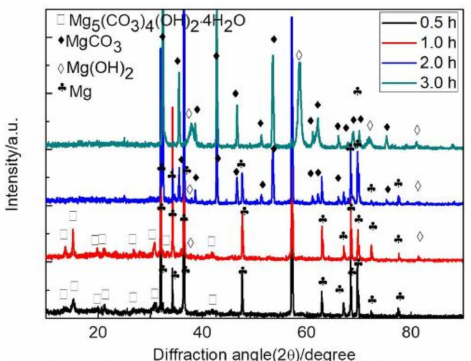
Figure 2. XRD patterns of samples HT0.5, HT1, HT2 and HT3 prepared by hydrothermal treatment in 0.5 M NaHCO 3 at 200 ◦ C for 0.5, 1, 2 and 3 h respectively.